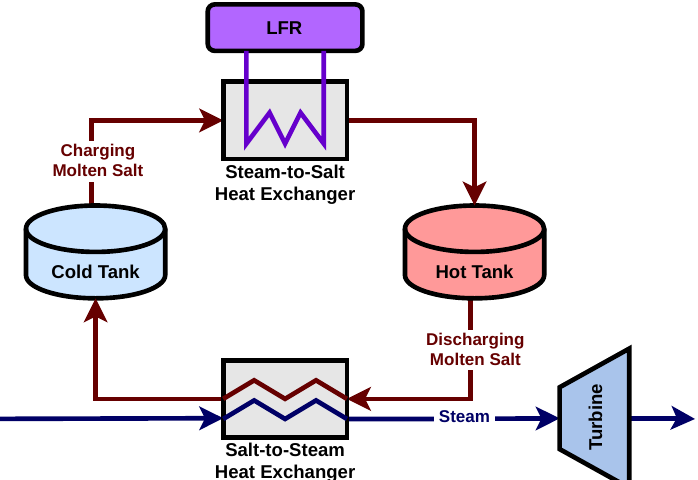
Figure 1. Schematic of LFR-molten salt flow loop. LFR heats (via secondary steam loop) the molten salt that flows from the cold to hot storage tanks. The hot tank can then discharge heat to the power cycle leading up to the steam